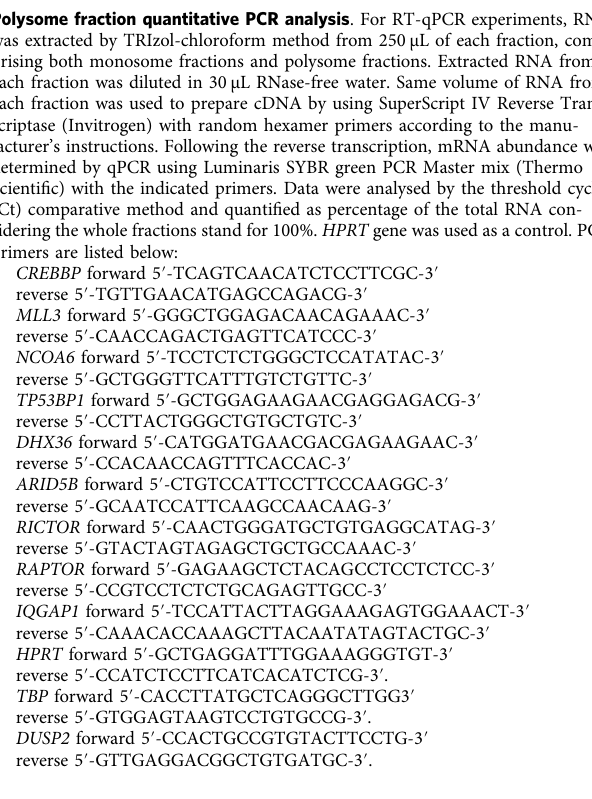
DUSP2 forward 5 ′ -CCACTGCCGTGTACTTCCTG-3 ′ reverse 5 ′ -GTTGAGGACGGCTGTGATGC-3 ′ . Lentiviral shRNA stable cell lines . The pLKO.1 vector-based shRNA lentiviral constructs were purchased from Sigma TRC Mission shRNA library. All the shRNAs were chosen based on experimentally validated datasheet (Sigma). Len- tivirus was packaged by co-transfection of constructs with the third generation packaging plasmids pMD2.G, pRRE and pRSV/REV with Calfectin